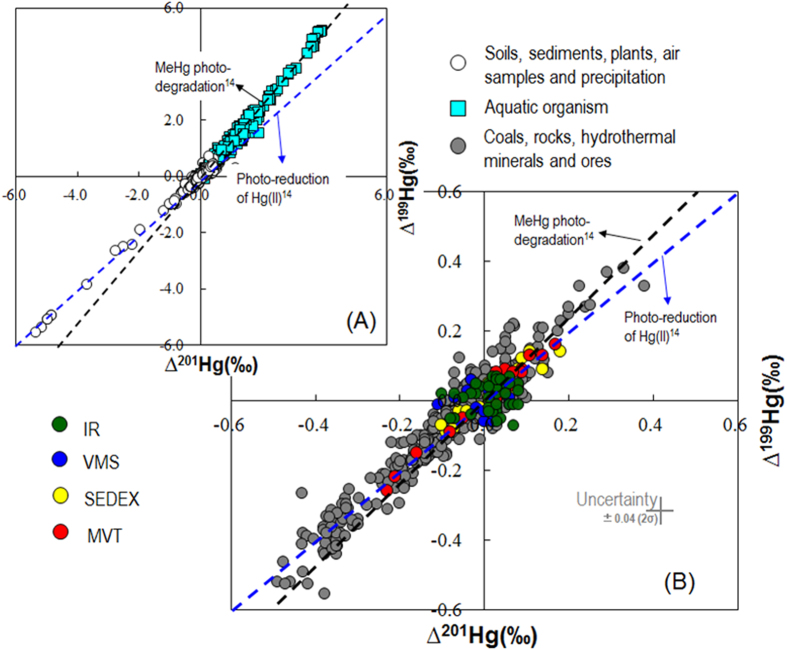
Plot of ∆199Hg versus ∆201Hg for different environmental samples (A based on previously published data summarized in Table S1) and sphalerites (B this study).The blue dashed line representing aqueous Hg(II) photoreduction14, has a slope of ~1.00. The black dashed line representing aqueous MeHg photodegradation14, has a slope of 1.36.